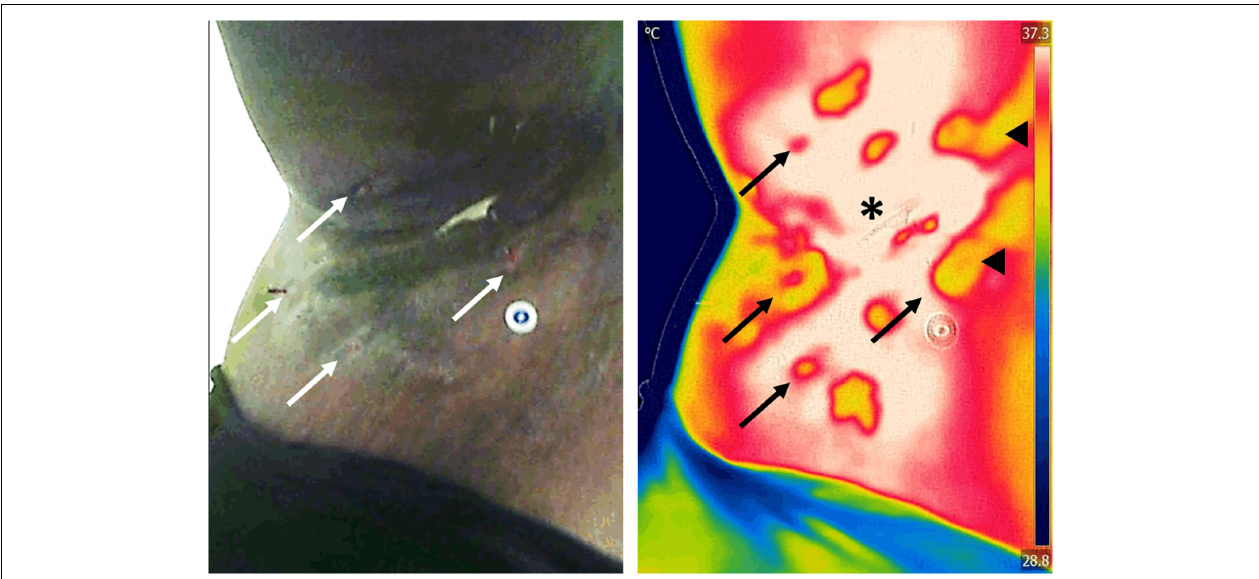
FIGURE 7 | Assessment of inflammation in a patient with hidradenitis suppurativa. Infrared thermography was used to assess the severity and area of inflammation in a patient with hidradenitis suppurativa. Assessment of the area of inflammation on regular clinical photographs (left) is challenging in patients with darker skin tones, which leads to subjective patient severity scoring. In contrast, because infrared thermography images (right) are impervious to skin color, hotspots (asterisk) can easily be used to map the extent of inflammatory changes. Previous research has demonstrated that the area of inflammation and its temperature gradient highly correlate with current clinical scores, offering a powerful insight into the underlying condition. Furthermore, thermography is able to identify open wounds (arrows) and tunneling in the dermis (arrowheads) that may not be evident to clinical inspection alone. Images, courtesy of Dr. Sheila C. Wang and JR-G, were acquired using the Skin and Wound mobile app (Swift Medical Inc., Toronto, ON, Canada) paired to a FLIR One Pro mobile